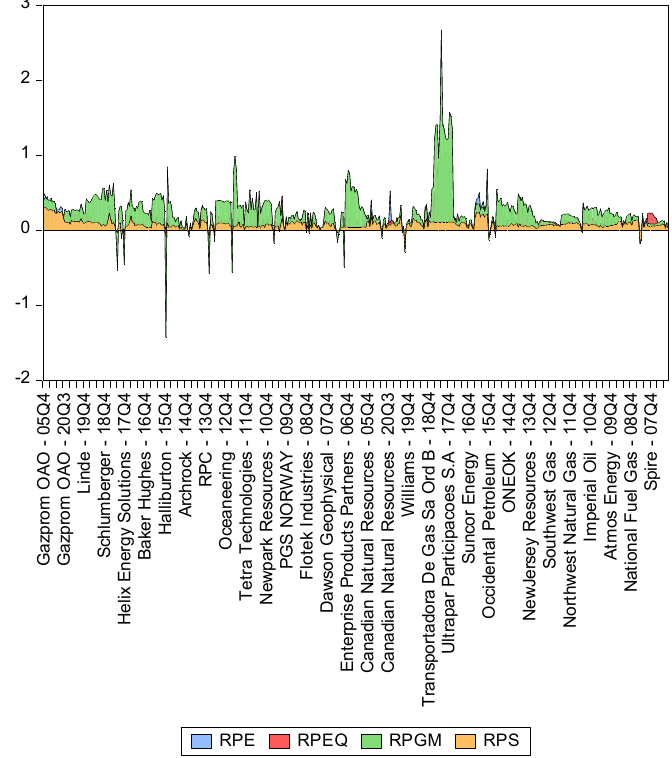
Figure 6. Evolution of fiscal pressure indicators for gas companies. According to Figure 7, the 29 oil companies registered a non-monotonic evolution of their fiscal pressure indicators during the analyzed period.